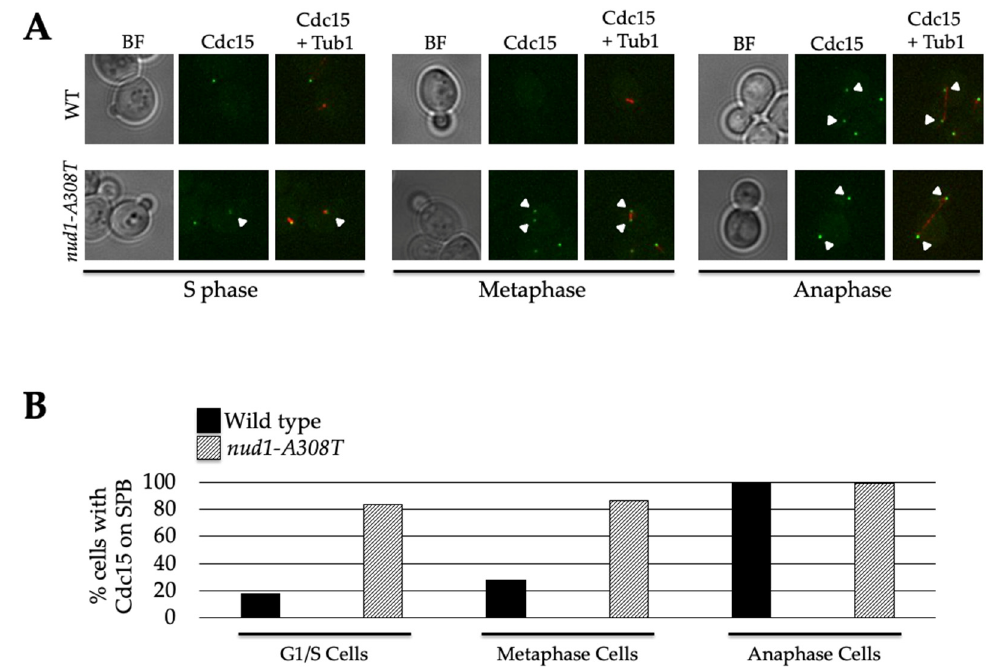
Figure 6. Cdc15 is recruited to SPBs in all cell cycle phases in nud1-A308T cells. Wild-type (AS513) and nud1-A308T (AS517) cells harboring Cdc15-eGFP and Tub1-mCherry fusions were grown to log phase in SC + glucose medium and living cells were imaged. ( A ) Brighfield (BF), Cdc15, and Cdc15 and Tub1 composite representative wild-type and nud1-A308T cells from S phase, metaphase, and anaphase are shown. Arrows indicate Cdc15 localization to SPBs. ( B ) The percentage of G1/S, metaphase, and anaphase cells containing Cdc15 on one or more SPBs in wild-type (black) or nud1-A308T (striped) cells is plotted ( n ≥ 80 cells for each stage).